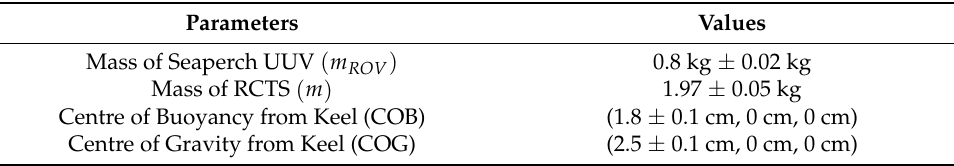
Table 2. RCTS parameters.